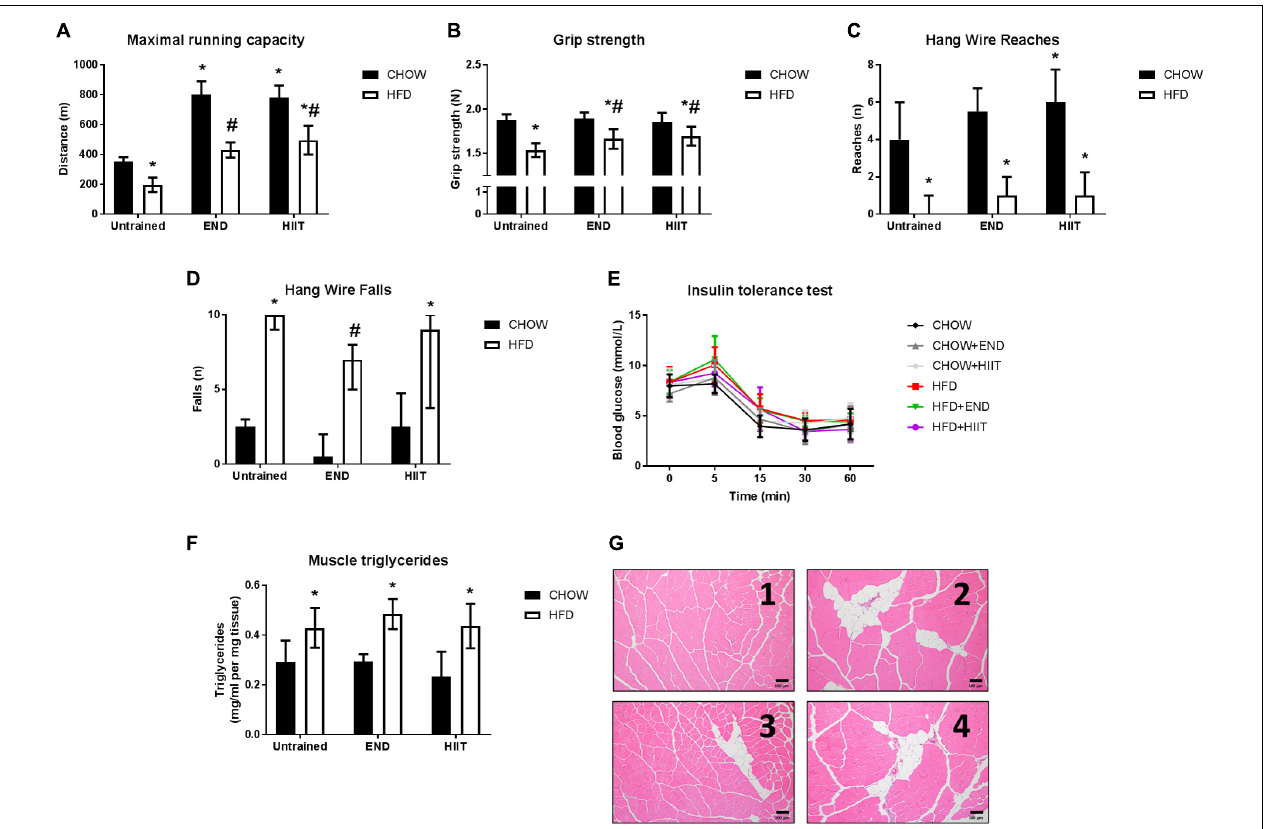
FIGURE 1 | Muscle function, structure, and systemic insulin sensitivity after training. (A) Distance covered in the maximal running capacity test, (B) grip strength, (C) , number of reaches, (D) number of falls during the hang wire test, (E) blood excursion during the insulin tolerance test, (F) muscle triglycerides levels, and (G) representative cross-sectional quadriceps muscle sections, with haematoxylin and eosin staining at 10 × magnification for CHOW untrained (1), HFD untrained (2), HFD+END (3), and HFD+HIIT (4). Data are presented as mean ± SD (A,B,E) and median [IQR] (C,D) with n = 6–12 animals per group. ∗ p < 0.05 vs. CHOW untrained; # p < 0.05 vs. HFD untrained by Two-way ANOVA with Tukey’s and Sidak’s post hoc tests. Statistical analysis for blood glucose excursion during the insulin tolerance test ( Figure 1E ) is described in Table 2 .